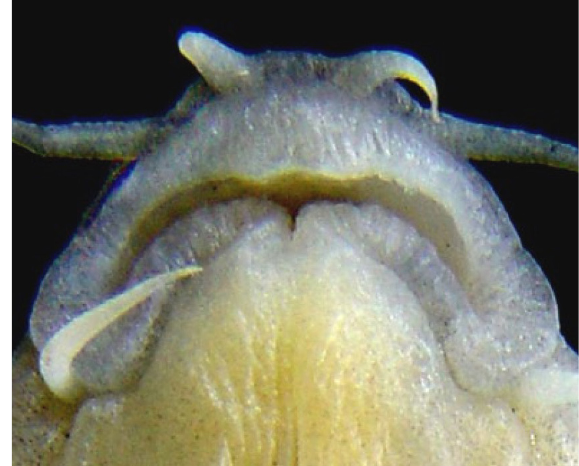
1mmImage 2. Lips of Schistura fasciata sp.